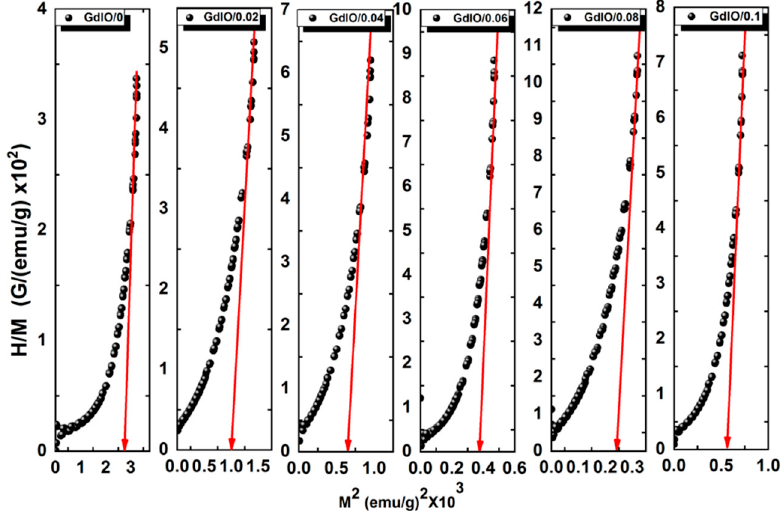
Figure 6. Magnetization curves for samples Gd IO/0, Gd IO/0.02, Gd IO/0.04, Gd IO/0.06, Gd IO/0.08 and Gd IO/0.1 ( left ) and magnetization for the small applied field to show the coercivity of samples ( right ).